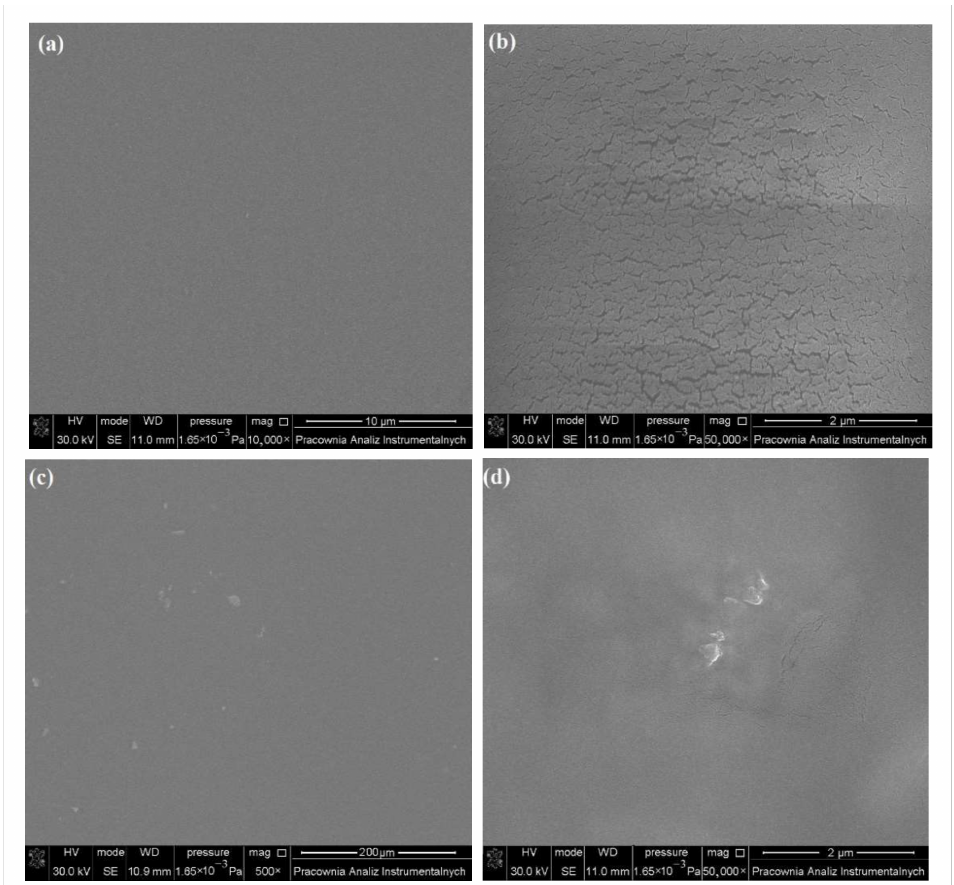
Figure 4. SEM images of the surface of levan films before irradiation ( a ) and after 44 h of irradiation with polychromatic lamp ( b ) and LED lamp ( c , d ).